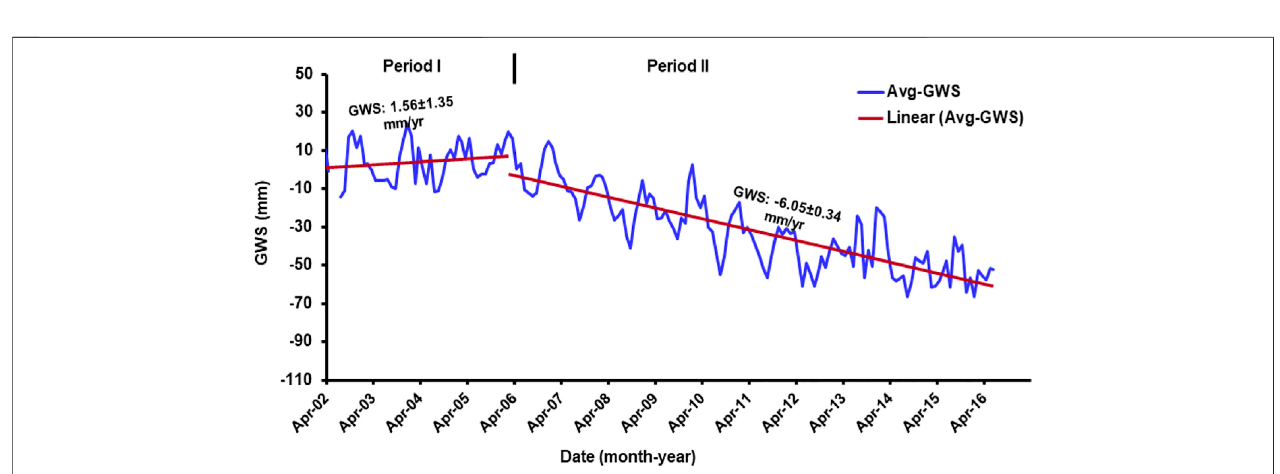
FIGURE 13 | Time series for the averaging groundwater storage variations from the monthly spherical harmonic and Mascon solutions over the whole study area.